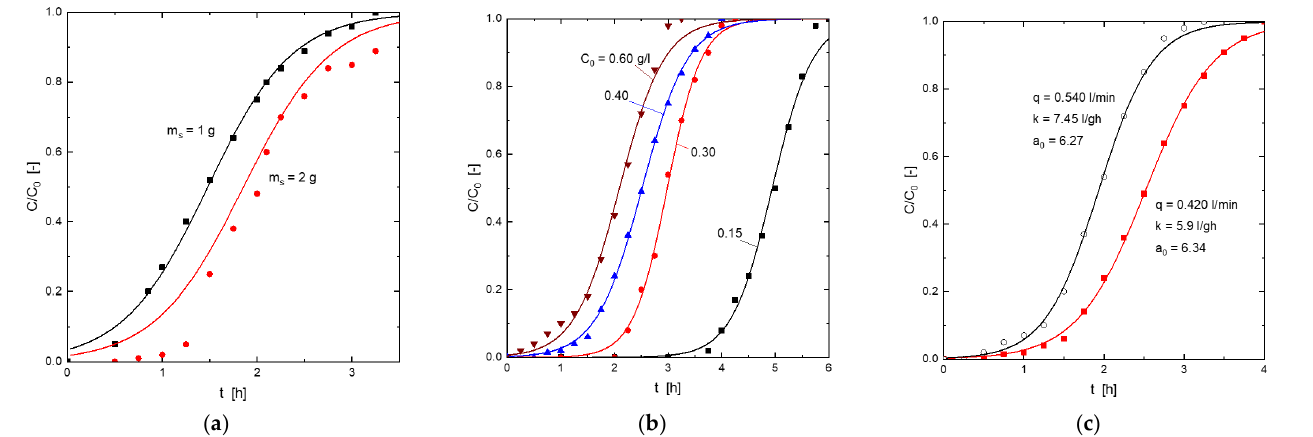
Figure 6. Experimental (symbols) and model (Equations (5) and (6)) (lines) breakthrough curves for the adsorption of H 2 S onto the goethite-based adsorbent. ( a ) Influence of the adsorbent dosage. ( b ) Influence of the H 2 S concentration in the gas mixture. ( c ) Influence of the gas mixture flow. Figure 7 represented the different experimental (symbols) and calculated (from Equation (10)) efficiency values for the different operational conditions used in the present work. An excellent fit between the values was found.